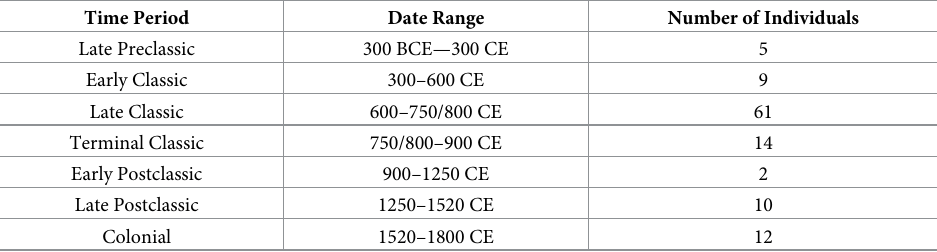
Table 1. Time periods, associated age ranges, and sample sizes for burials (total n = 114) analyzed in this